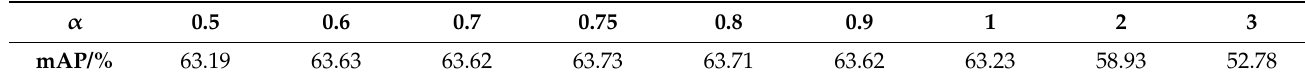
Table 4. Effects of different values of α on the detection